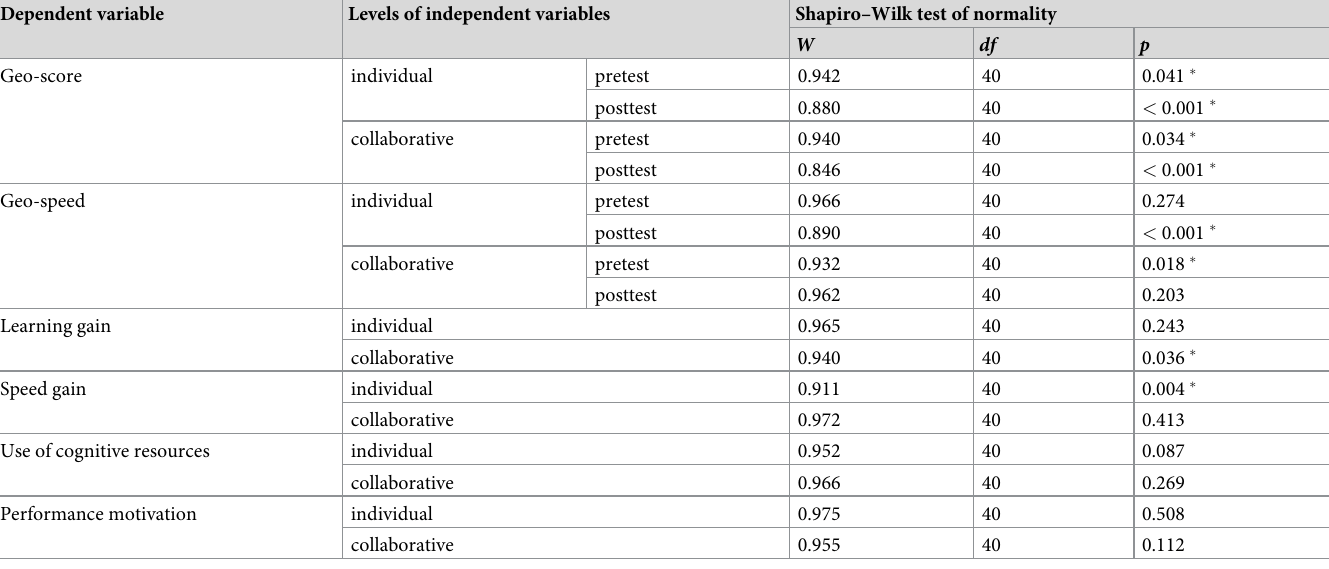
Table 2. Overview of the dependent variables. Dependent variable Levels of independent variables